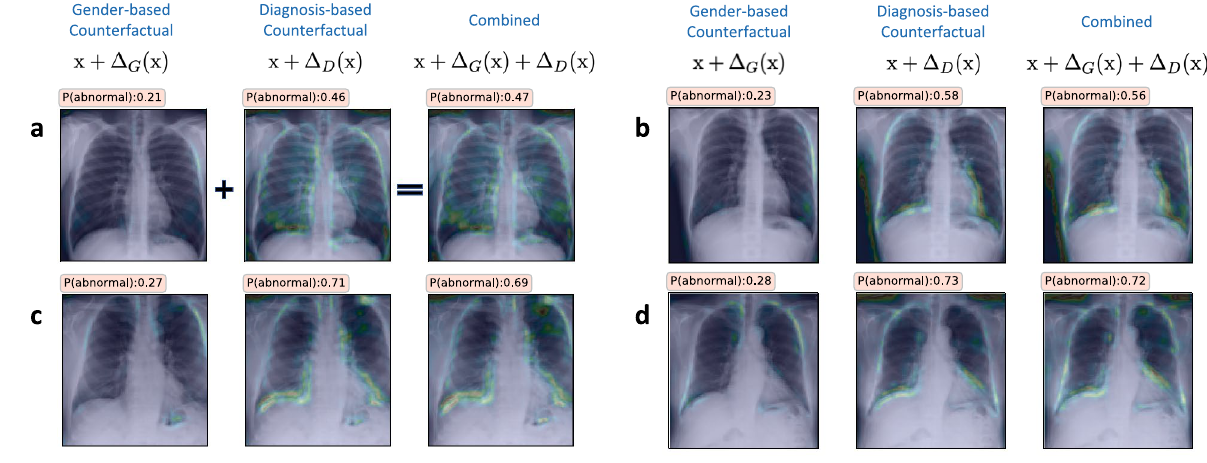
Figure 6. ( a – d ) Explanations generated using TraCE by introducing gender-specific attributes into the counterfactuals synthesized for changing the diagnosis state of a normal subject to be abnormal . In contrast to the age attribute, image manipulations associated with change in gender (female → male) do not cause any apparent change to the likelihood of being assigned to the abnormal group. In each case, we highlight the changes � A ( x ) , � D ( x ) , � A ( x ) + � D ( x ) and show the likelihood P ( state = abnormal ) .